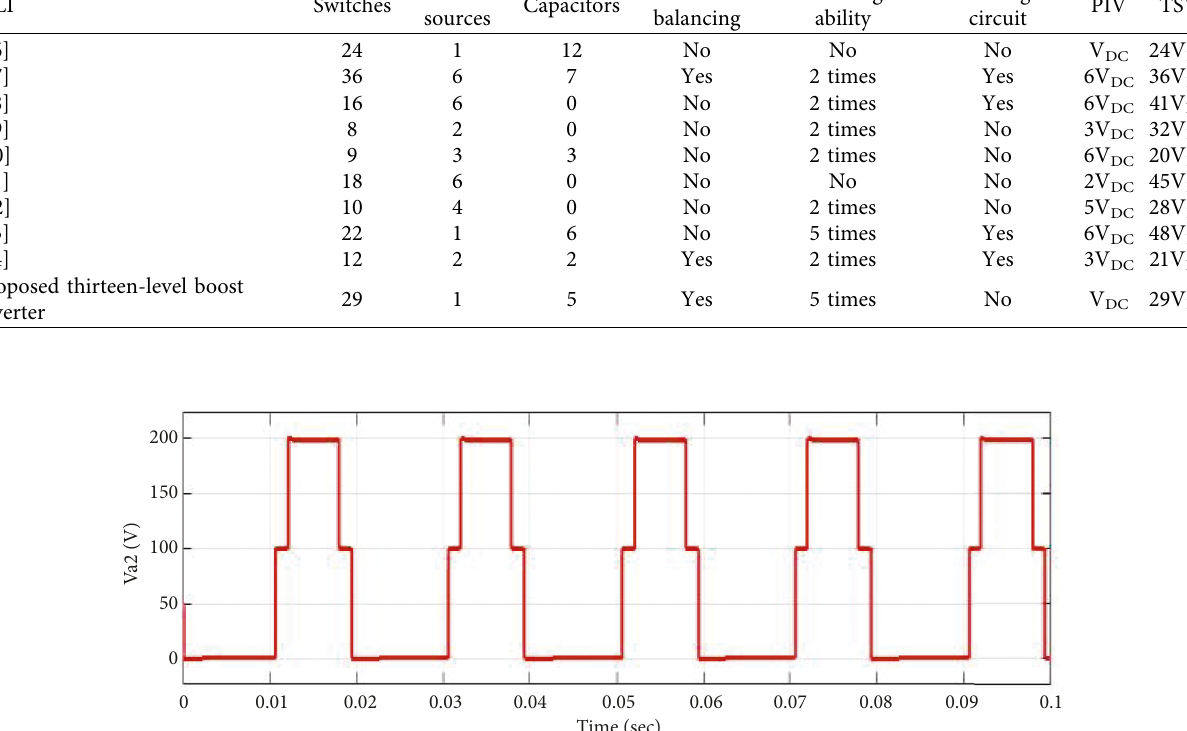
Table 4: Comparison results between existing topologies and the proposed topology. MLI